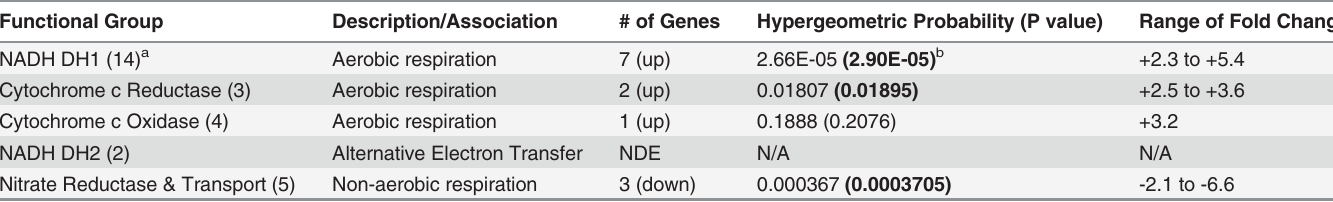
Table 3. Differentially expressed functional categories indicative of M . tb respiratory and metabolic state in type II AEC. Functional